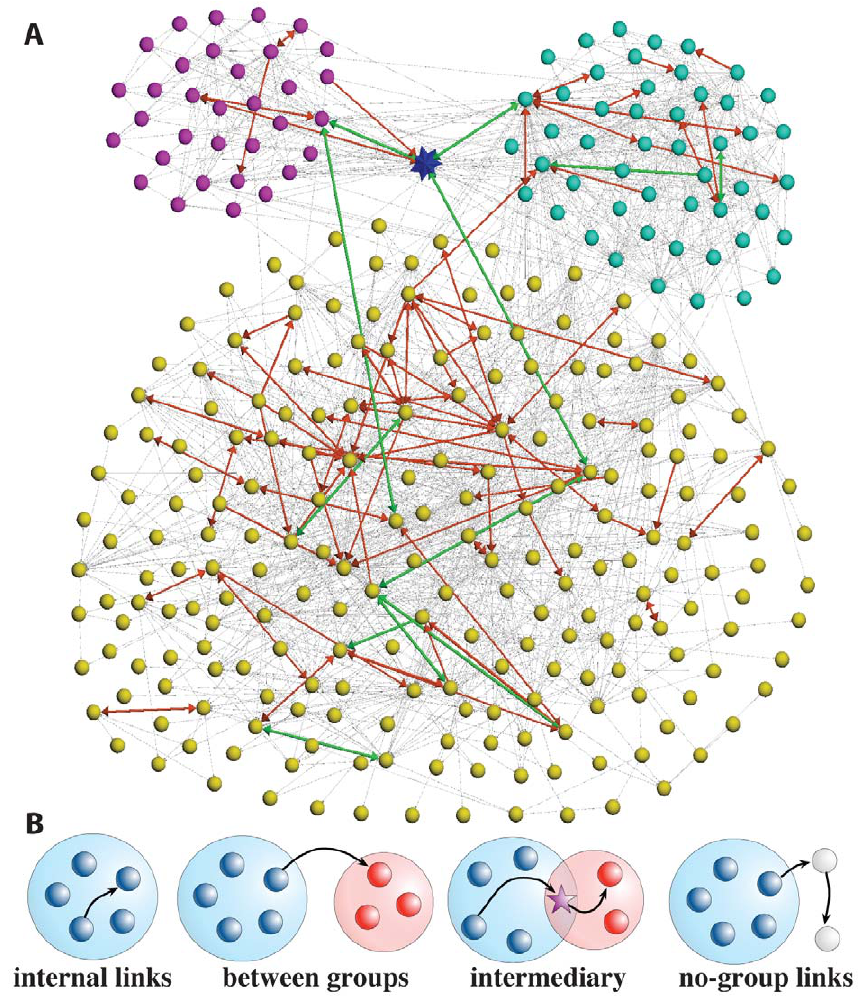
Figure 1. Groups and links. (A) Sample of Twitter network: nodes represent users and links, interactions. The follower connections are plotted as gray arrows, mentions in red, and retweets in green. The width of the arrows is proportional to the number of times that the link has been used for mentions. We display three groups (yellow, purple and turquoise) and a user (blue star) belonging to two groups. (B) Different types of links depending on their position with respect to the groups’ structure: internal, between groups, intermediary links and no-group links.